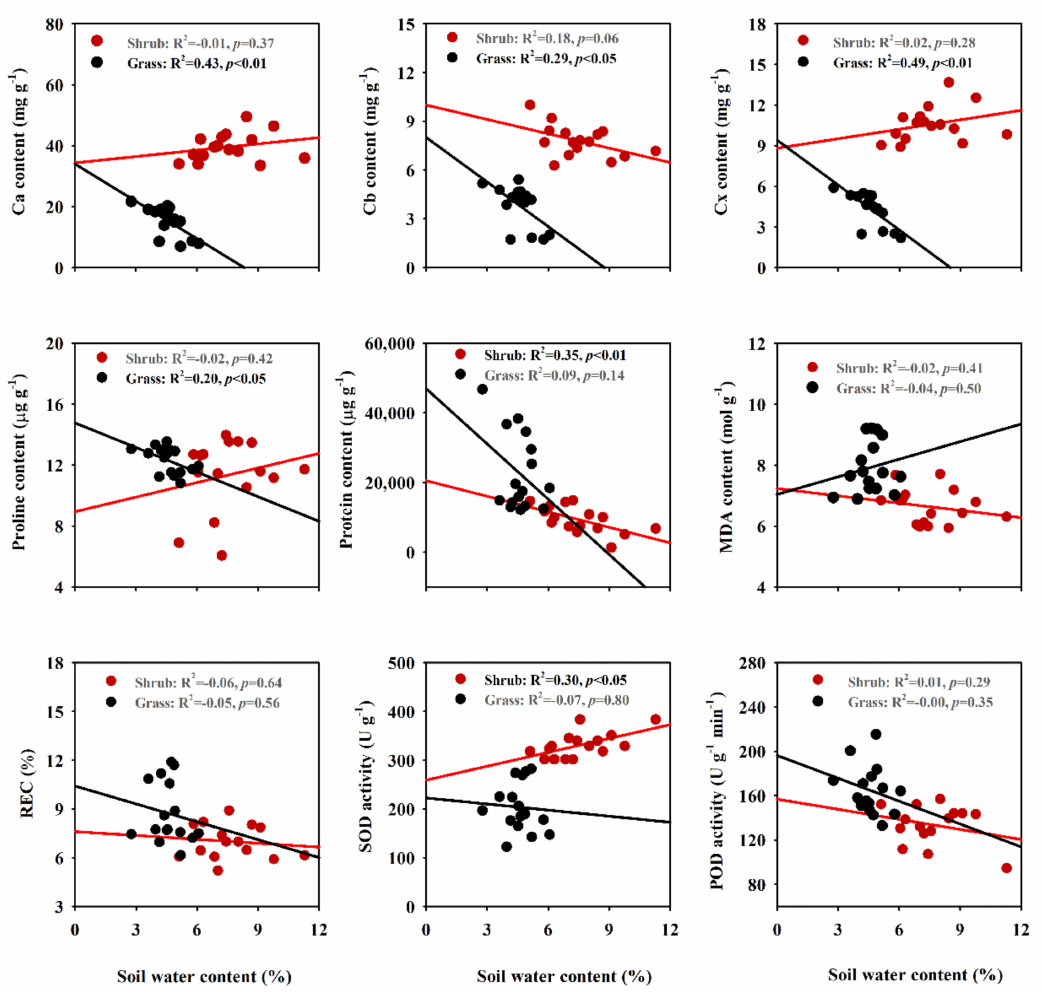
Figure 4. Correlations between soil water content and biochemical traits of Stipa glareosa in the shrub- and grass-dominated communities. Ca, chlorophyll a; Cb, chlorophyll b; Cx, carotenoids; MDA, malondialaenyde; REC, relative electrical conductivity; SOD, superoxide dismutase; POD,